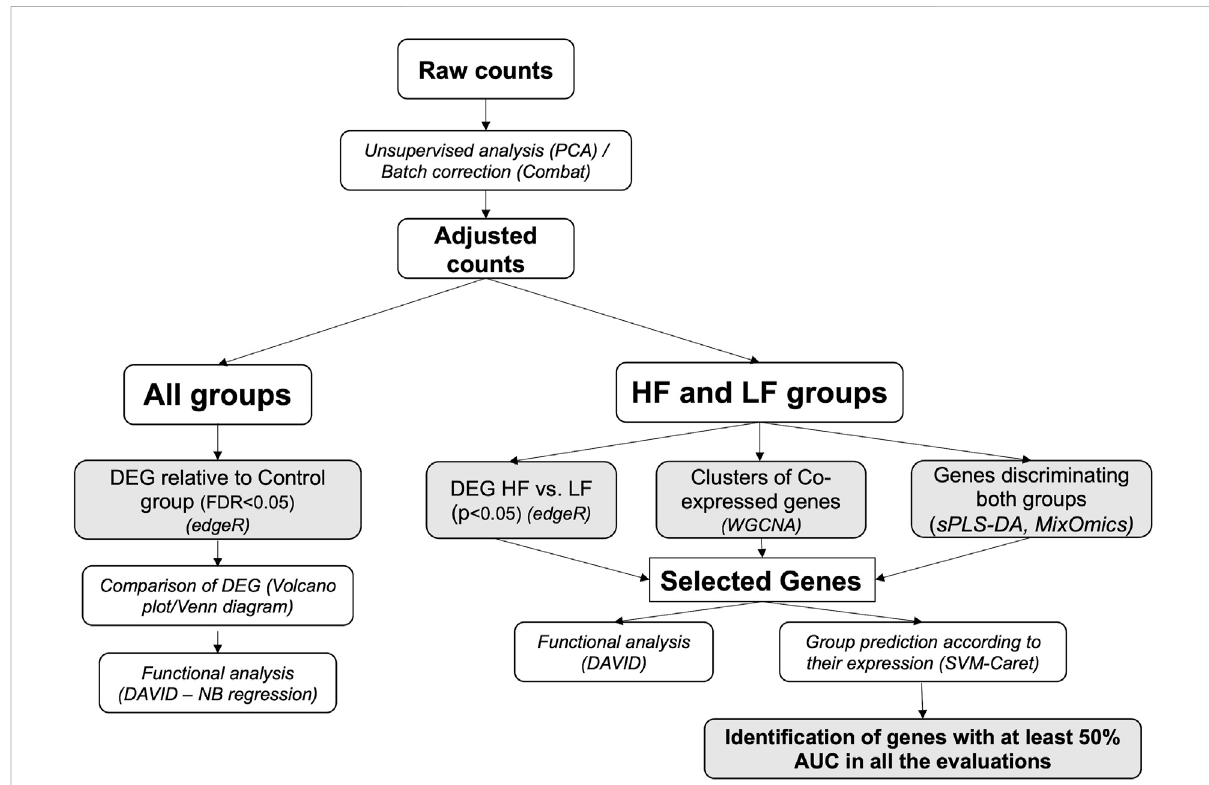
FIGURE 2 Bioinformatics pipeline. The scheme represents the work fl ow employed in the analysis of RNAseq data obtained from endometrial explants exposedtonothing(Control),interferontau,oraDay15conceptusfromahighfertility(HF)orlowfertility(LF)bull.Themethodsaredetailedinitalics (thesoftwareusedisinparenthesis).Shadedsquaresdenotethemainoutputs fromthestudy.PCA:principalcomponentanalysis;DEG:differentially expressed genes; WGCNA: weighted-gene co-expression network analysis; sPLS-DA: sparse partial least square-discriminant analysis; DAVID: Database for Annotation, Visualization and Integrated Discovery; AUC: area under the